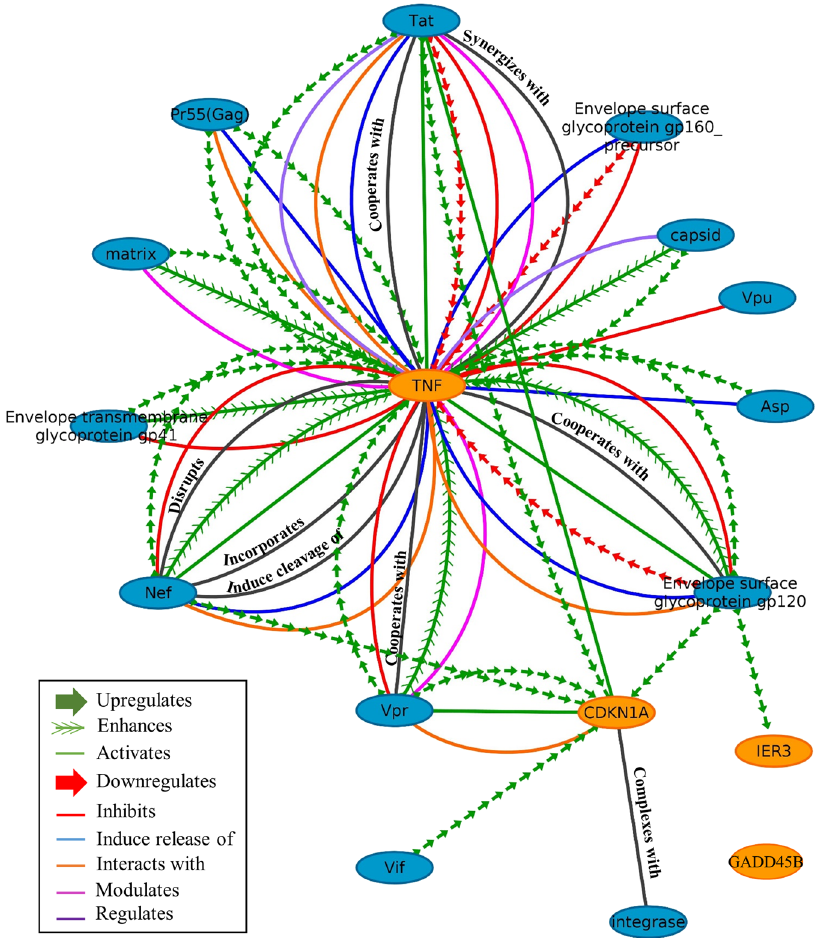
Figure 6. Protein-protein interaction network of CDKN1A, TNF, IER3 and GADD45B with viral proteins. The whole HIV-1 human interaction database was downloaded and all the interactions of CDKN1A, TNF, IER3 and GADD45B with viral proteins were